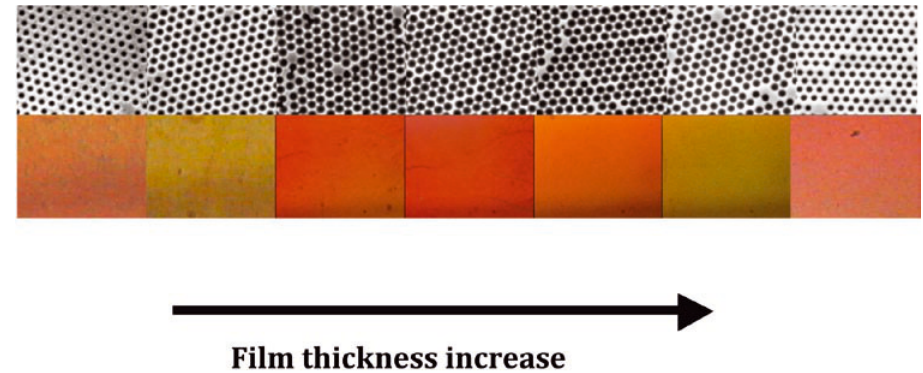
Figure 3. SEM images and the corresponding optical images for a graded, nanostructured gold film grown through a 500 nm sphere diameter template. The arrow shows the direction of the increasing of the film